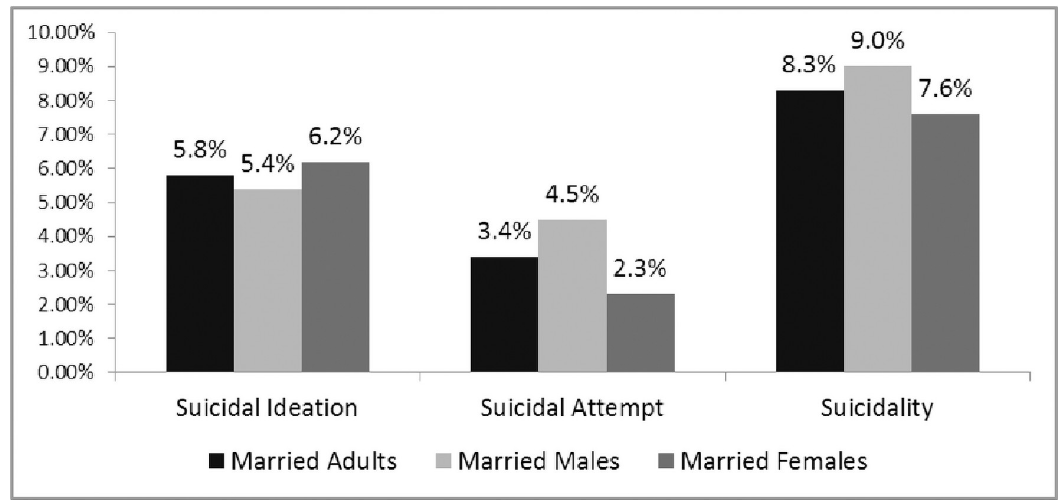
Fig 1. Prevalence of suicidal ideation, suicidal attempt, and suicidality among married adults in Rajshahi City, Bangladesh.